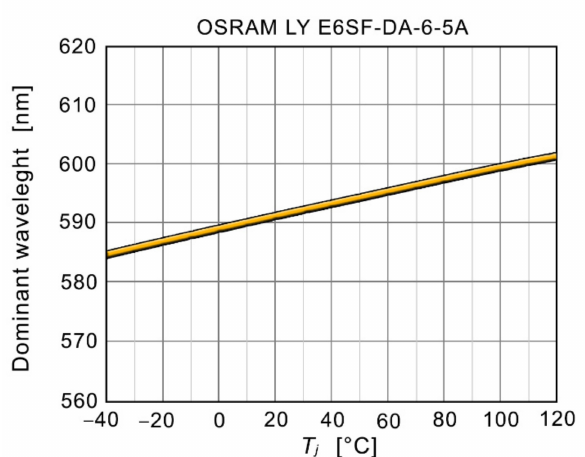
Figure 6. LY E6SF LEDs: changes in dominant wavelength as a function of temperature [19].